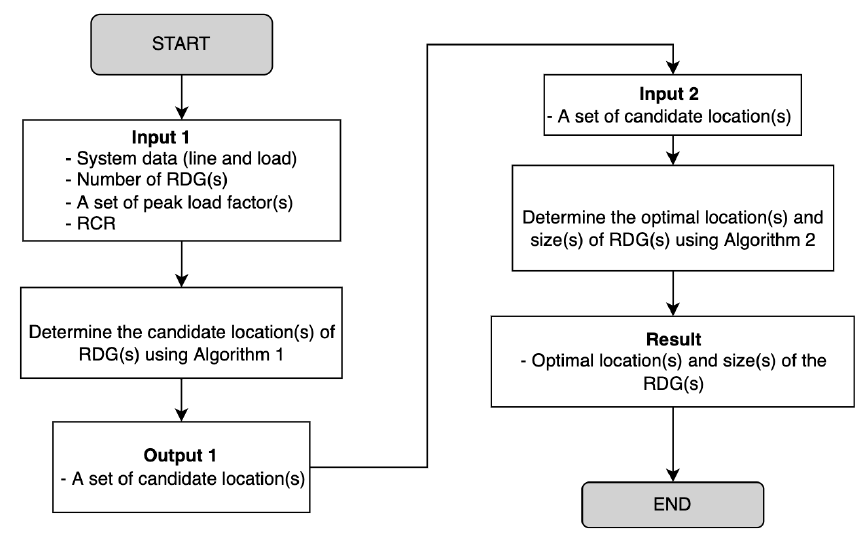
Figure 4. A flowchart of the proposed method.